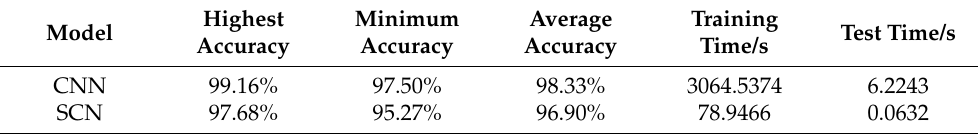
Table 4. Recognition accuracy and average running time of six-classifying